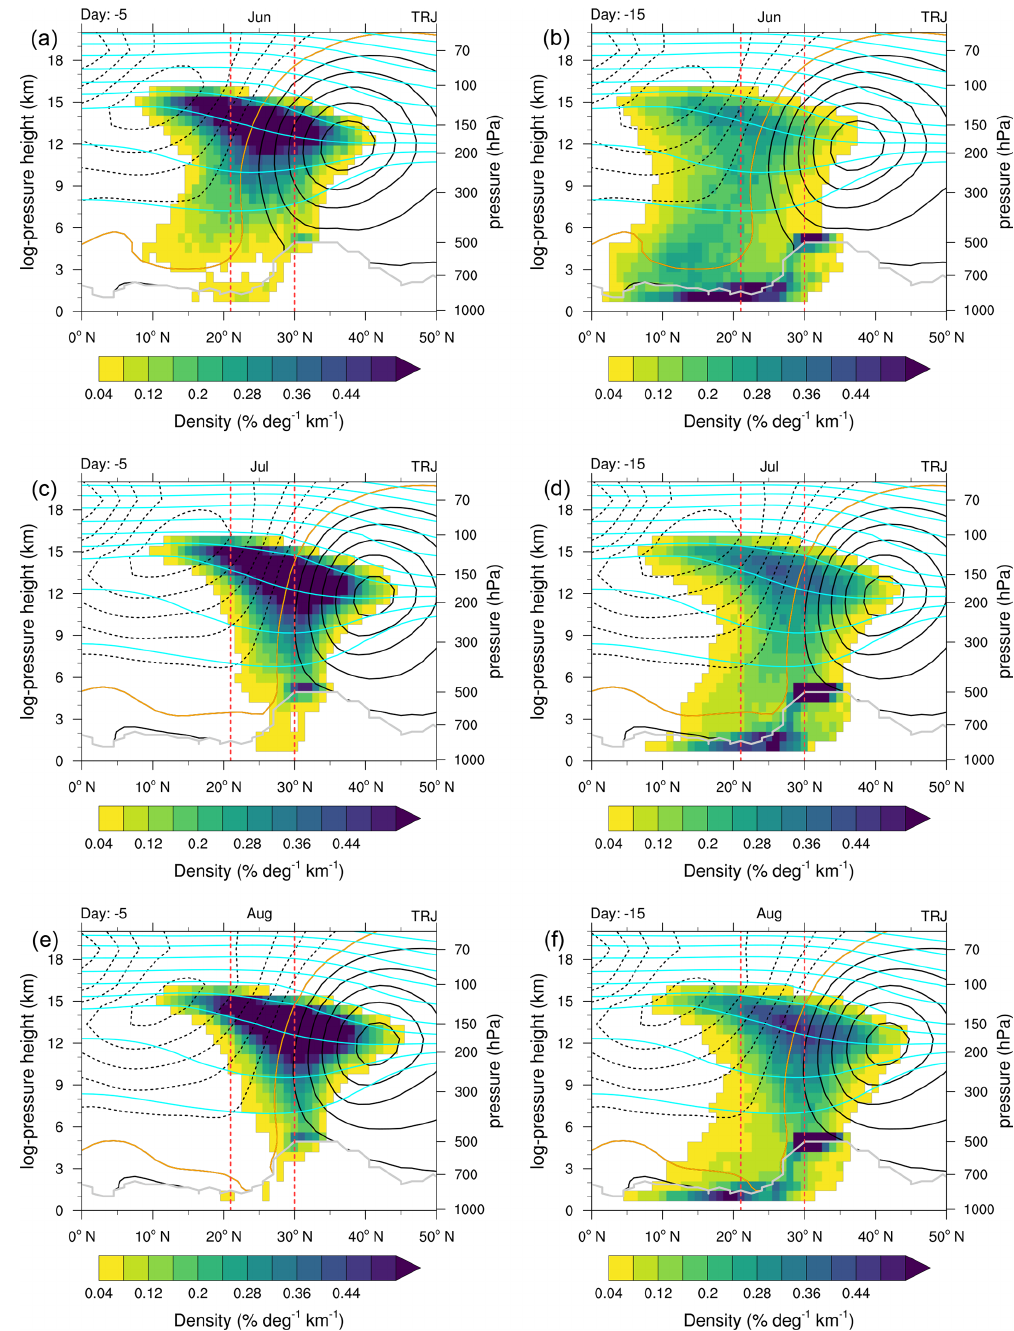
Figure 12. As in Fig. 6 for (a, c, e) 5 and (b, d, f) 15d prior to their final position at 150hPa, split according to (a, b) June, (c, d) July and (e, f) August. Again the three-dimensional probabilities were integrated over 60–140 ◦ E. For orientation purposes, dashed vertical red lines at 21 and 30 ◦ N roughly indicate the maxima in the distributions between 6 and 12km for June and August for the trajectories 15d prior to their arrival at 150hPa, respectively. Meteorological data from ERA-Interim are presented as in Fig. 6 but separated for June, July and August, respectively. At the bottom, data were flagged with the same criterion as in Fig. 6.